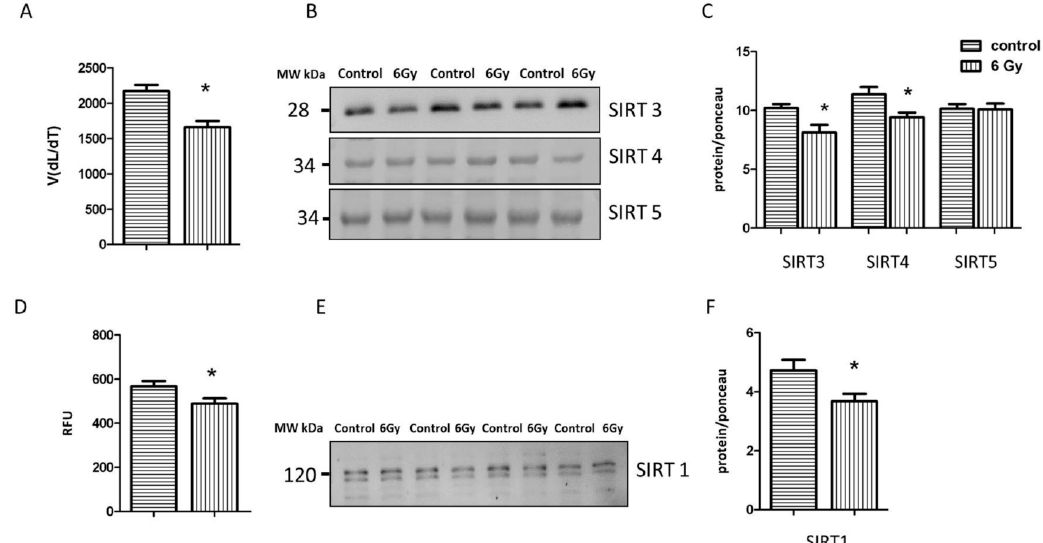
Figure 6. Analysis of the sirtuin proteinsactivity and expression. The activity of sirtuin proteins was measured in mitochondria fraction using pan-SIRT assay. The error bars represent standard error of the mean ( ± SEM) (t-test; * p < 0.05; n = 3) ( A ). Immunoblotting analysis of SIRT3, SIRT4, SIRT5 was performed in the mitochondrial lysates from each group ( B , C ). The columns represent the average ratios of relative protein expression in control and irradiated samples after background correction (t-test; * p < 0.05; n = 3) ( C ). The activity of SIRT1 was compared between irradiated and control samples (t-test; * p < 0.05; n = 4) ( D ). Immunoblotting analysis of SIRT1 was performed using whole heart lysate. The error bars represent standard error of the mean (t-test; * p < 0.05; n = 4) ( E , F ). The amount of the total protein was measured by Ponceau S staining for an accurate comparison between the groups. The error bars represent standard error of the mean ( ± SEM) (t-test; * p < 0.05; n = 3).